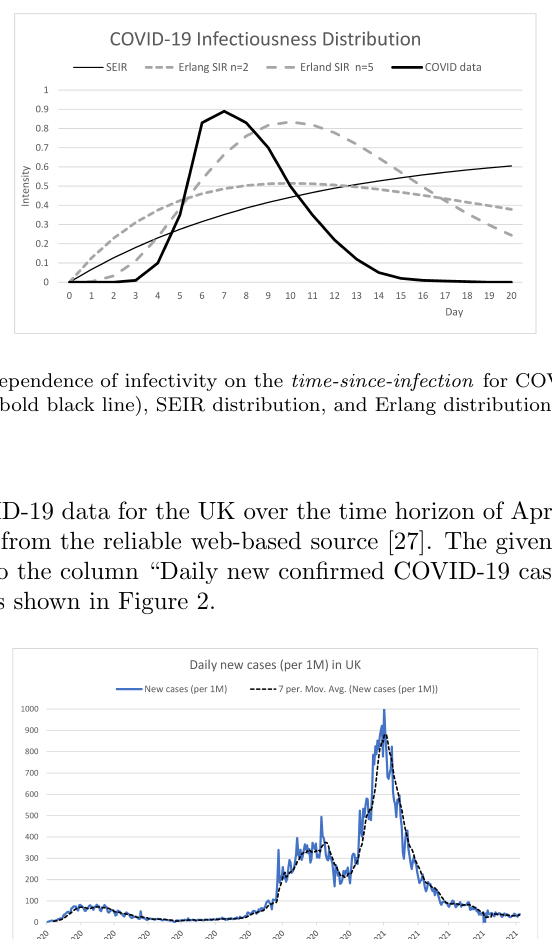
Figure 2. The dynamics of new infected individuals in the UK for April 2020 – May 2021, taken from (Our World in Data